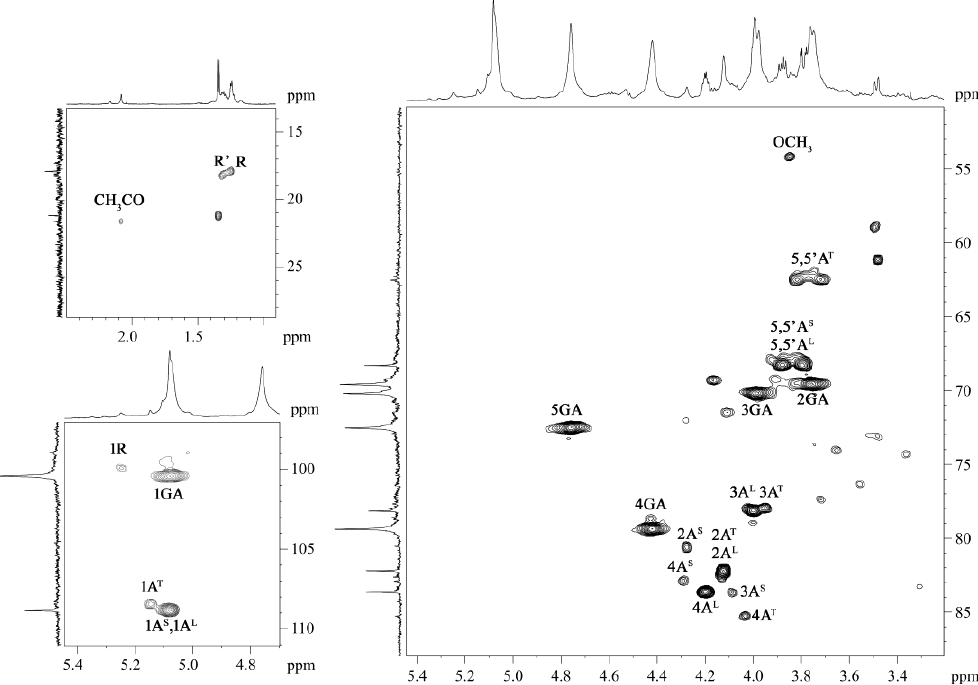
Figure 4. Parts of 1 H, 13 C HSQC spectrum of the SO1-2 . The corresponding parts of the 1 H and 13 C NMR spectra are shown along the X and Y axes, respectively. Arabic numerals refer to the carbon atoms in the residues, as designated in Table 2.